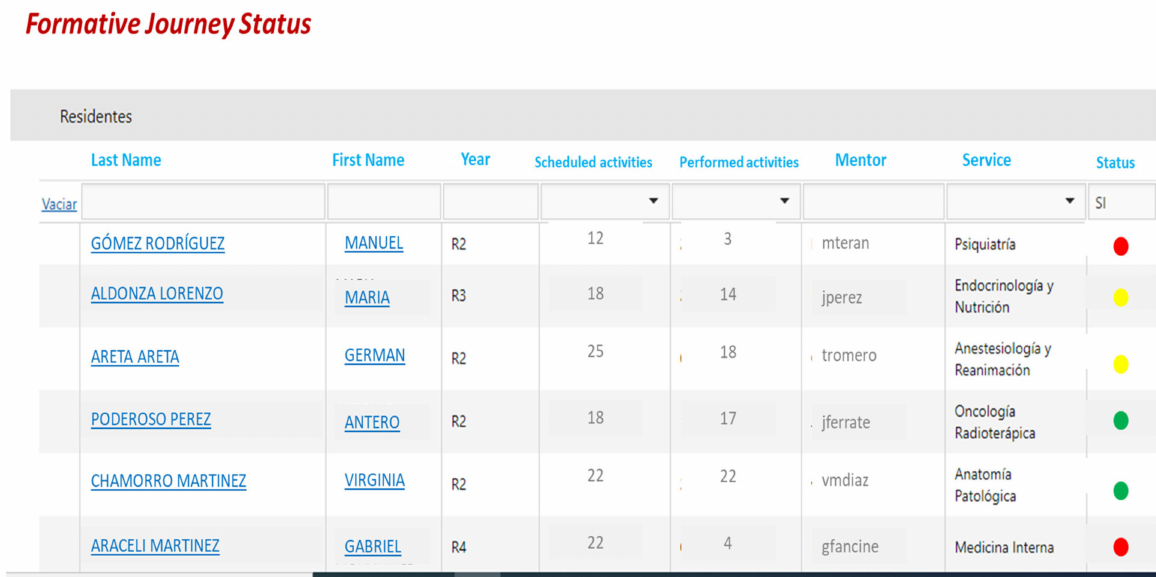
Figure 4. Registration of a User Training Itinerary (Screenshot). Note: Completed (green), In Progress (yellow), and None Achieved (red) goals are displayed in the final column (Status—of the